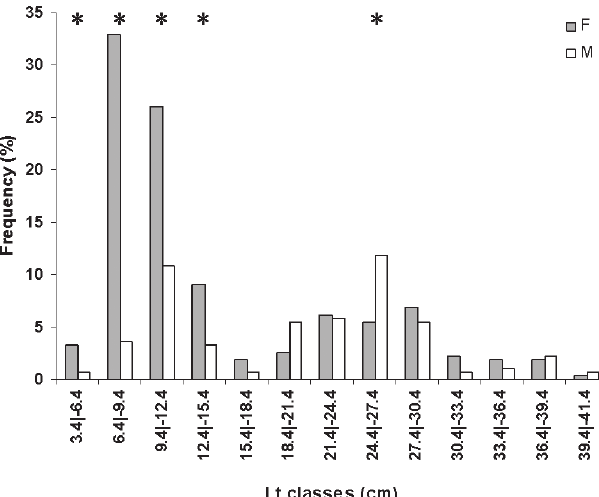
Fig. 3. Distribution of the absolute frequencies of occurrence of females and males of Cichla kelberi in the total length classes – Lt - (cm) in Lobo Reservoir during the study period. (Legend: * sex ratio different than 1:1).